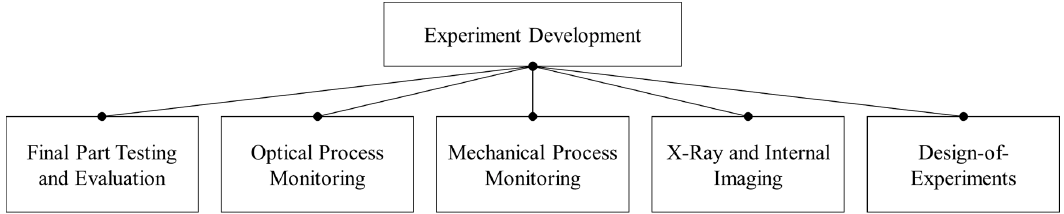
Figure 9. Experiment development categories